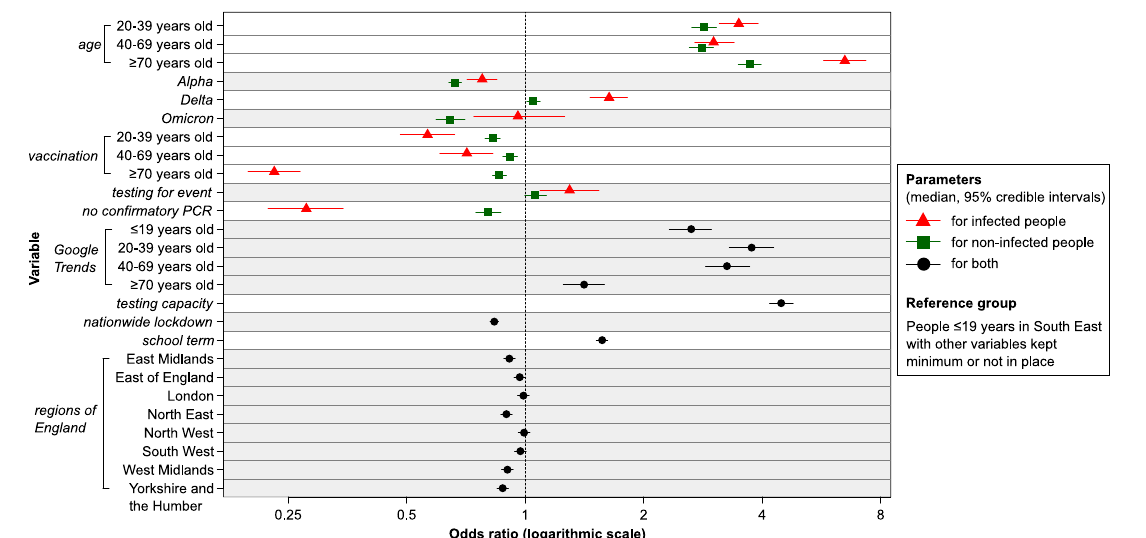
Fig. 2 | Odds ratios for taking a SARS-CoV-2 PCR test from the best- fi tting model. The x -axis shows odds ratios on a logarithmic scale, and the y -axis shows variablesincludedinthebest- fi ttingmodel.Pointsandhorizontallinescorrespond to median and 95% credible intervals, respectively, estimated for the infected (red andtriangle),non-infected(greenandsquare),orboth(blackandcircles).Infected (or non-infected) people aged ≤ 19years (age group 1) in South East, with other variables kept minimum or not in place, represented the reference group for